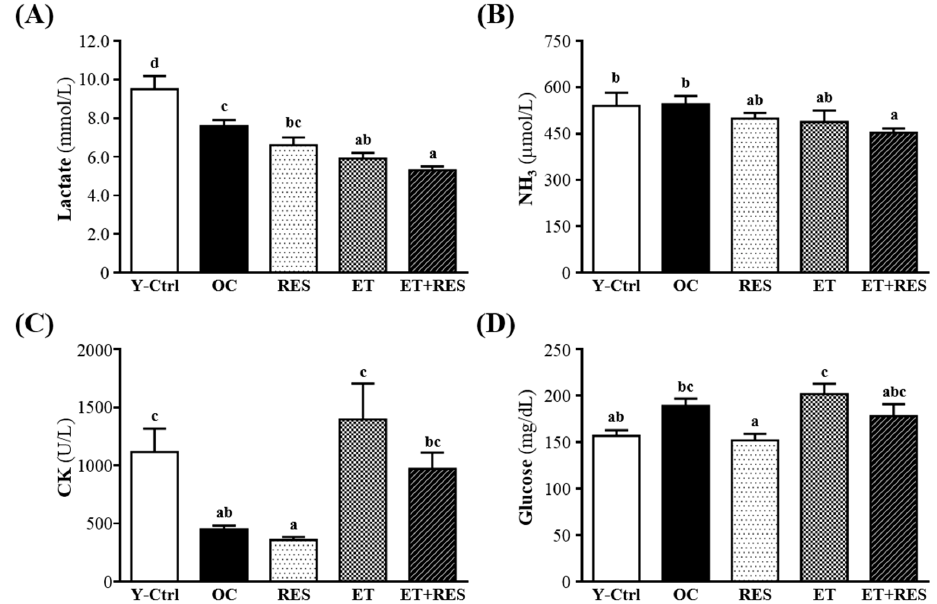
Figure 2. Effect of 4-week resveratrol (RES) supplementation and exercise training (ET) on serum levels of ( A ) lactate, ( B ) ammonia (NH 3 ), ( C ) creatine kinase (CK), and ( D ) glucose after a 15-min swim test. Mice were pretreated with the vehicle, RES, ET, and ET+RES for 28 days. Data are the mean ± SEM. Different letters indicate a significant difference at p < 0.05 according to a one-way ANOVA. Y-Ctrl, a young control group; OC, an older control; RES, a supplementation with RES group; ET, a ET group; ET+RES, a combination of ET and RES supplementation group.